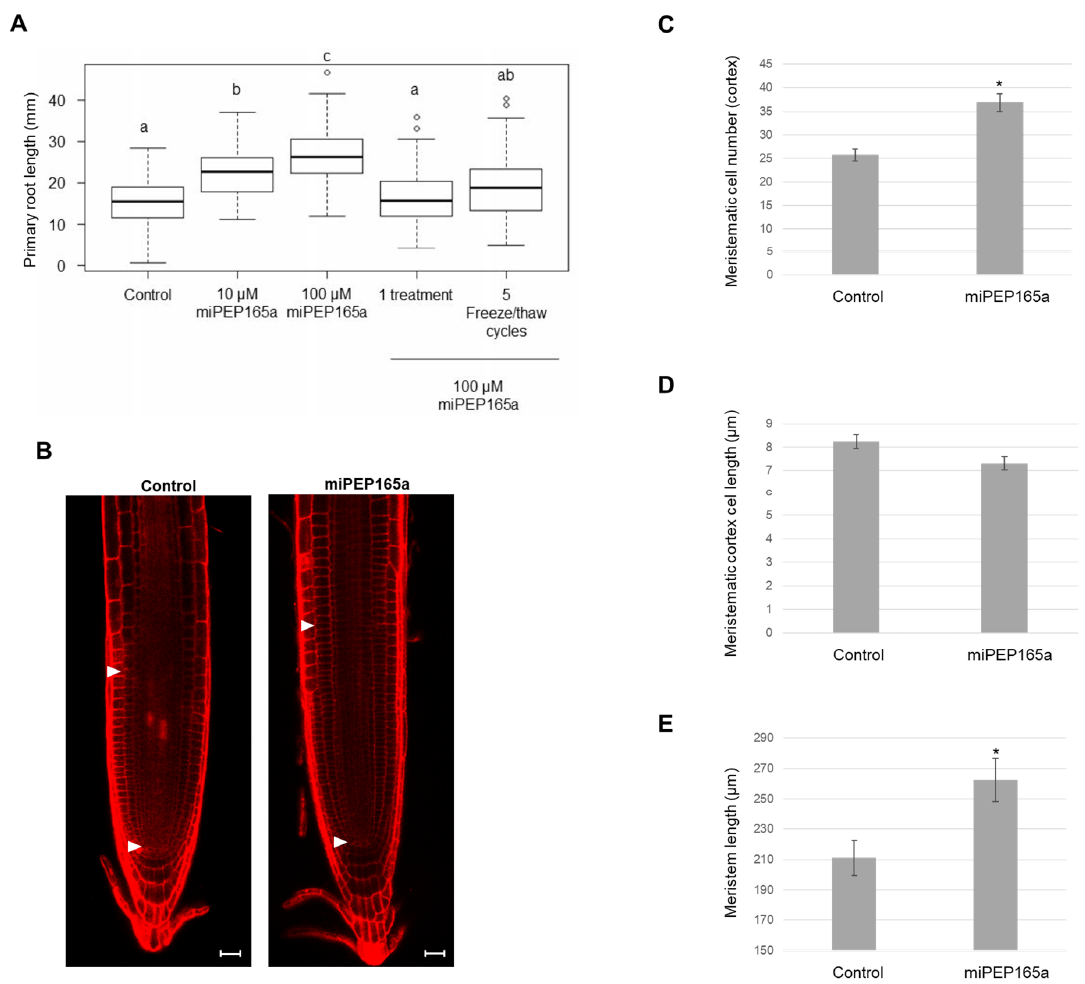
Figure 1. MiPEP165a promotes root growth by enhancing cell division. ( A ) Effect of miPEP165a on primary root length. Arabidopsis thaliana seedlings were treated with various concentrations of miPEP165a. Seedlings were treated daily with the peptide for 4 days, with the exception of those that received only one treatment. Peptides were thawed once, except those that underwent five freeze/thaw cycles. Two-way analysis of variance (ANOVA) significance levels were based on Tukey’s post-test (1-way ANOVA), (a–c, p < 0.05, n = 70). At least three biological replicates were performed ( B–E ). Three-day-old seedlings were treated daily with water or 100 µM miPEP165a for a further 3 days and stained with 10 µg/mL propidium iodide for 20 min. ( B ) Confocal images showing the meristematic zone for the cortex cells, defined as the region between quiescent center cells and the first elongating cell that was twice the length compared to its distal neighbor (distance between white arrows) [25,26]. Meristematic cell number ( C ) and cell length ( D ) were determined with the software tool Cell-o-Tape, an open source ImageJ/Fiji macro [27–29]. ( E ) Quantification of root apical meristem length. ( B–E ) Four biological replicates were performed with at least 20 seedlings. Errors bars represent SEM. Asterisks indicate a significant difference at p < 0.01 (*) according to the t-test. Scale bar = 25 µm. Water was used as a control.